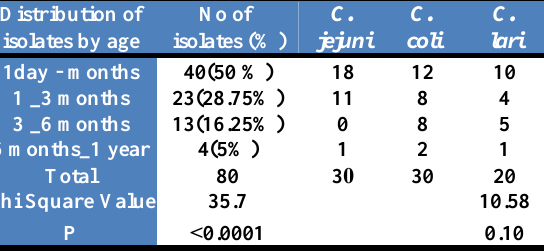
Table, 5: Isolation rates of Campylobacter spp. according to ages of animals.